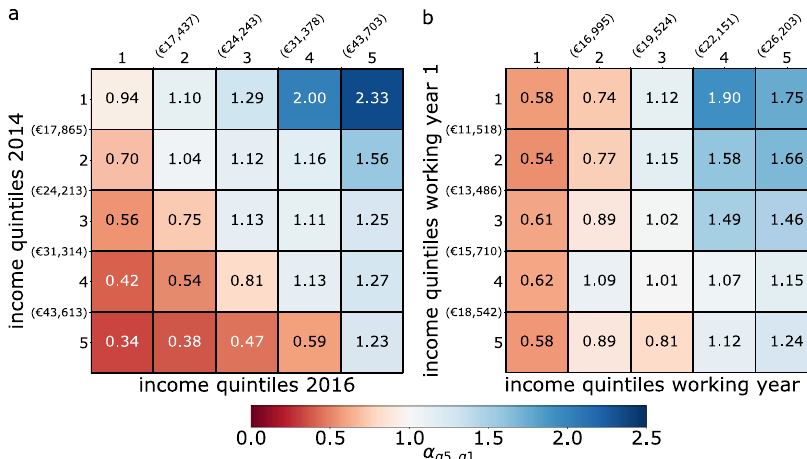
Fig. 2 Relative income mobility over a time span of three years for the Belgian customers of large European bank. We compare individuals starting in the highest quintile of fi nancial wealth relative to those starting in the lowest fi nancial wealth quintile (read from row to column). Panel a : results based on the sample of work-eligible customers. Panel b : results based on the sample of career